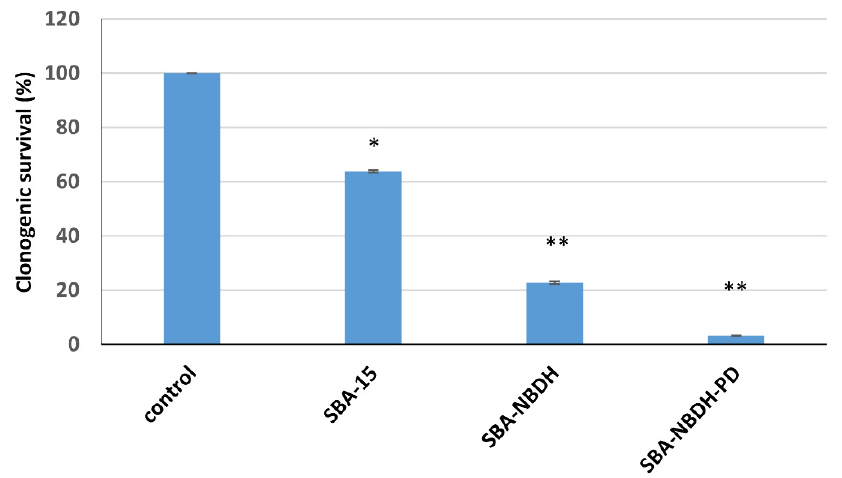
Figure 13. Clonogenic survival of B16 cells seeded in the colony formation assay after exposure to 125 µg/mL SBA-15, SBA-NBDH, and SBA-NBD-PD for 16 h. Data are presented as percentage of untreated control and are shown as mean ± SEM (n = 3). * 0.01 < p < 0.05, ** 0.001 < p < 0.01.